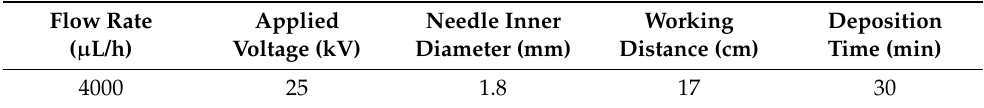
Table 1. Process parameters used for the electrospinning of PCL solution 12% w/v . Flow Rate Applied Needle Inner ( µ L/h) Diameter